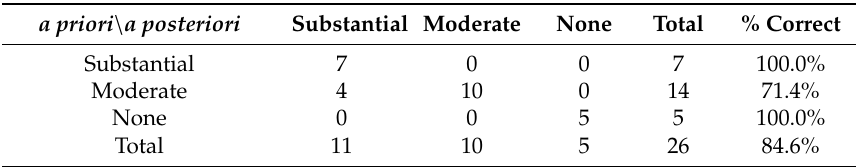
Table 5. Confusion matrix for factorial discriminant analysis of three categories of damage by the bark and ambrosia beetles